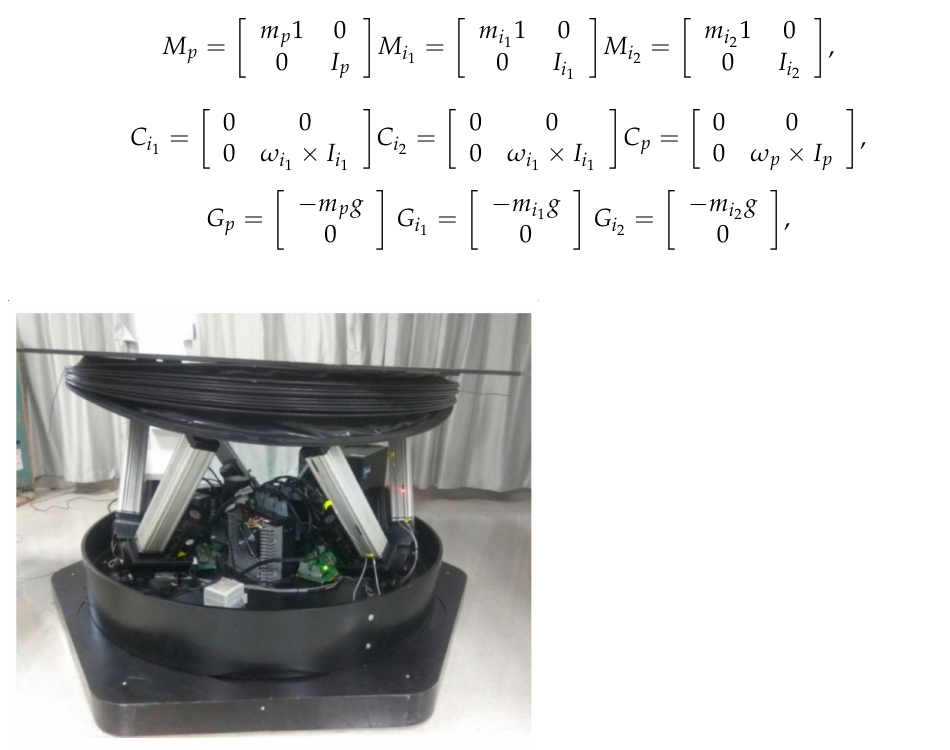
Figure 2. Six degrees of freedom (6-DOF) flight simulation experiment